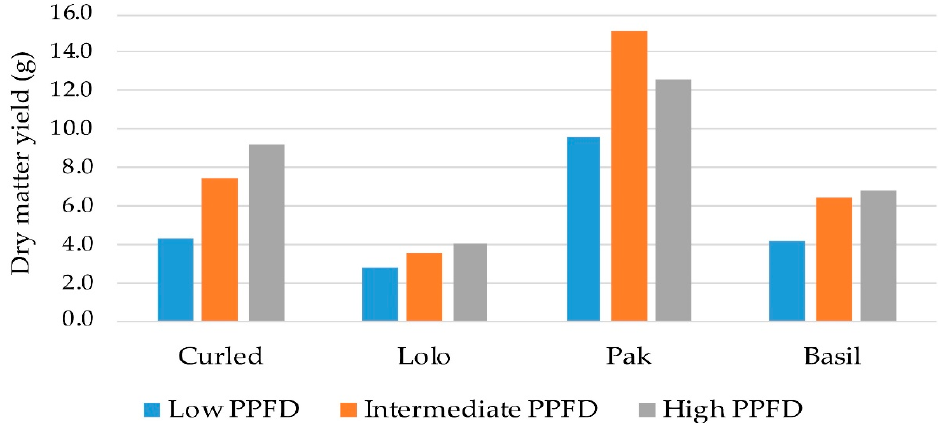
Figure 8. Dry matter (DM) yield of the crops under different photosynthetic photon flux density (PPFD) levels.